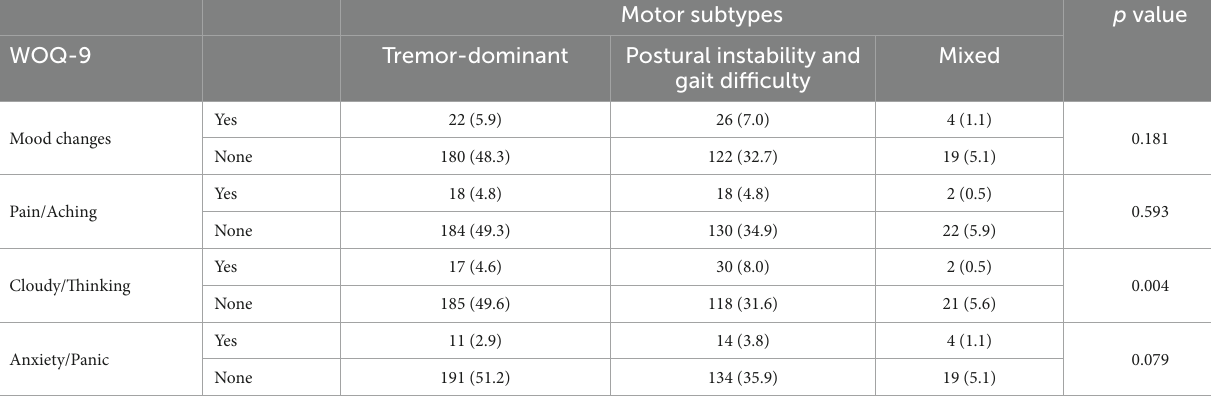
TABLE 4 Mood changes between PwPD with the three motor subtypes according to the results of WOQ-9; pain/aching between PwPD with the three motor subtypes according to the results of WOQ-9; cloudy/thinking between PwPD with the three motor subtypes according to the results of WOQ-9; and anxiety/Panic between PwPD with the three motor subtypes according to the results of